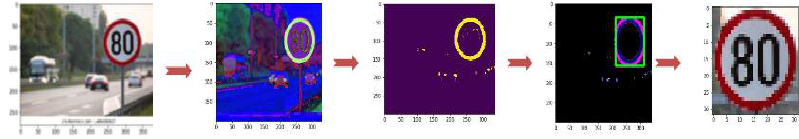
Fig. 5. An ex 2, showing traffic sign recognition and detection system.